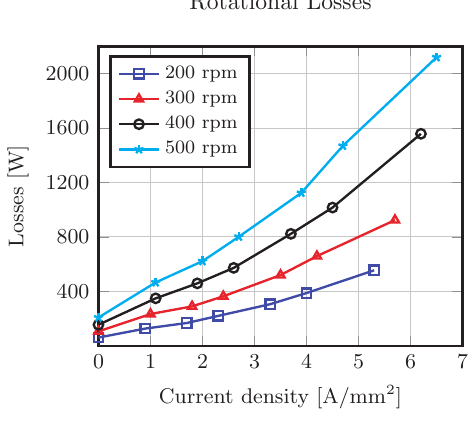
Figure 34. Measured rotational losses of the HM3D machine at various current densities.